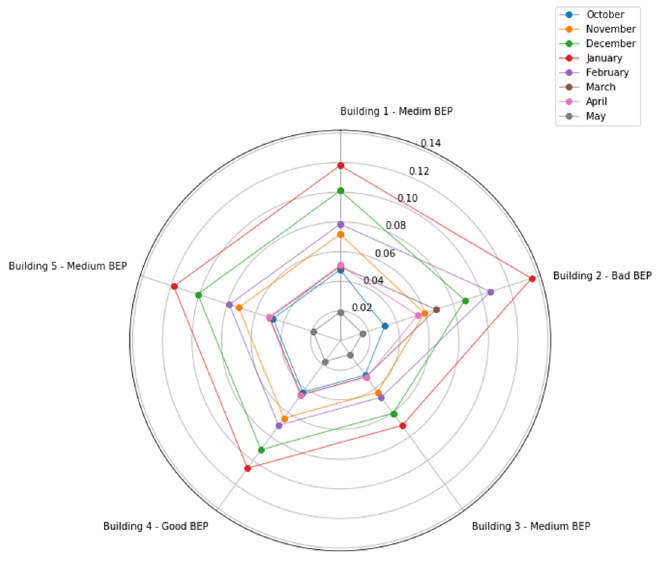
Figure 12. Daily energy savings on an average day for heating.